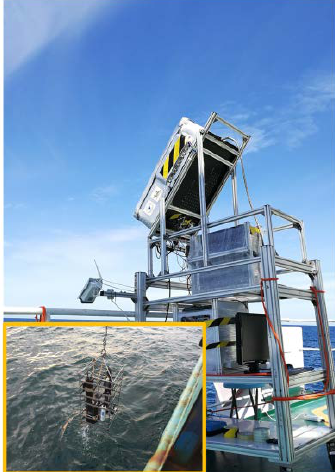
Fig. 1. The lidar field experiment in the Yellow Sea. Lidar system mounted on the fore deck of the ship and in situ instruments going into the water.